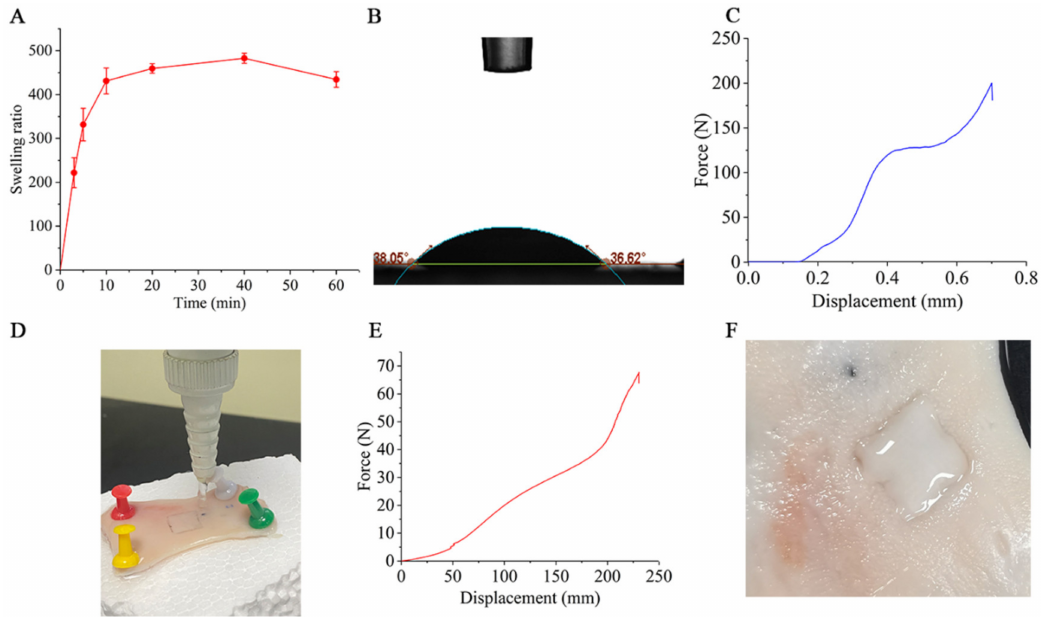
Figure 2. Evaluation of the physical properties of the PVA/CMC-Na blended film and the force curve of Li-HAMNs. ( A ) Results of the swelling performance of the blended film. ( B ) The static contact angle of the blended film surface. ( C ) The force curve of Li-HAMNs analyzed by the universal testing machine. ( D ) The photo of the flush test of the blended film. ( E ) The tensile stress curve of blend film analyzed by the universal testing machine. ( F ) Shape changes of artificial salivary infiltration of